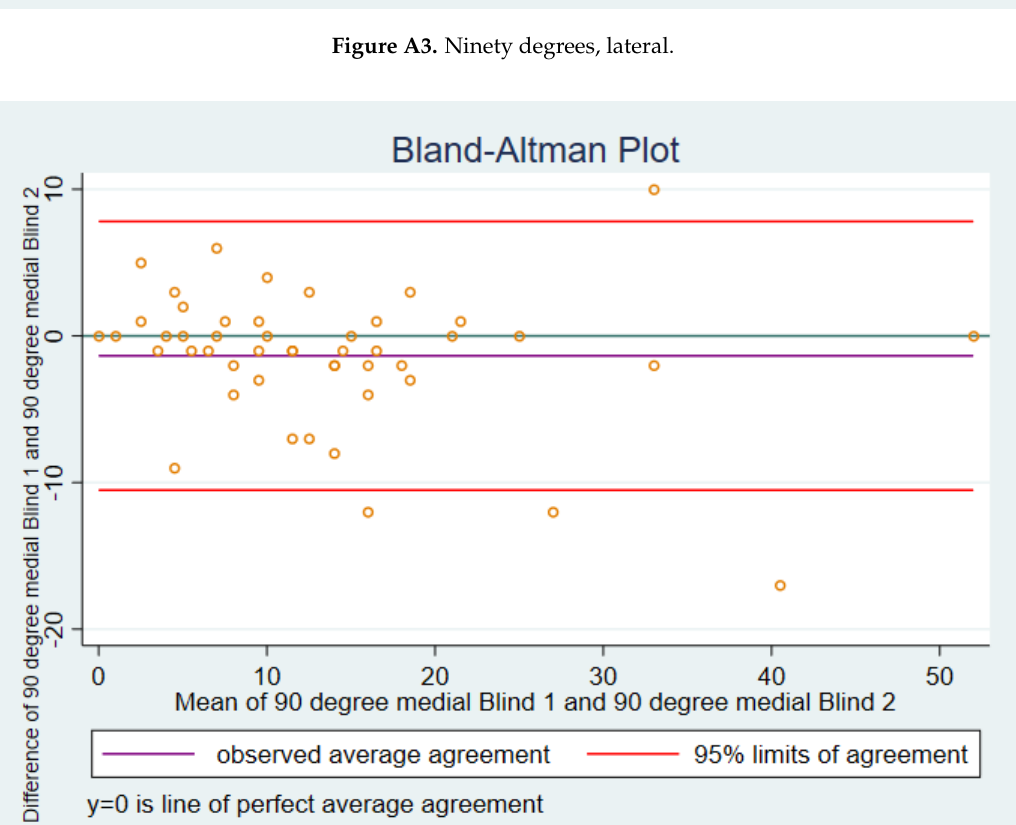
Figure A4. Ninety degrees, medial.